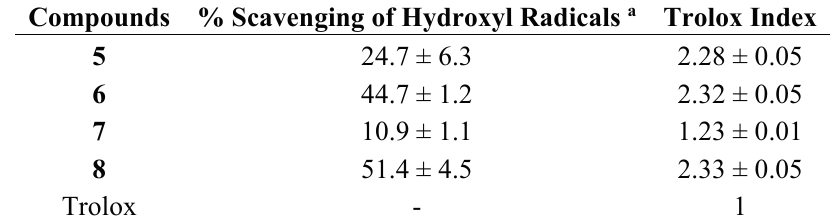
Table 3. Percentage of scavenging of hydroxyl radicals and Trolox index calculated for compounds 5 – 8 .